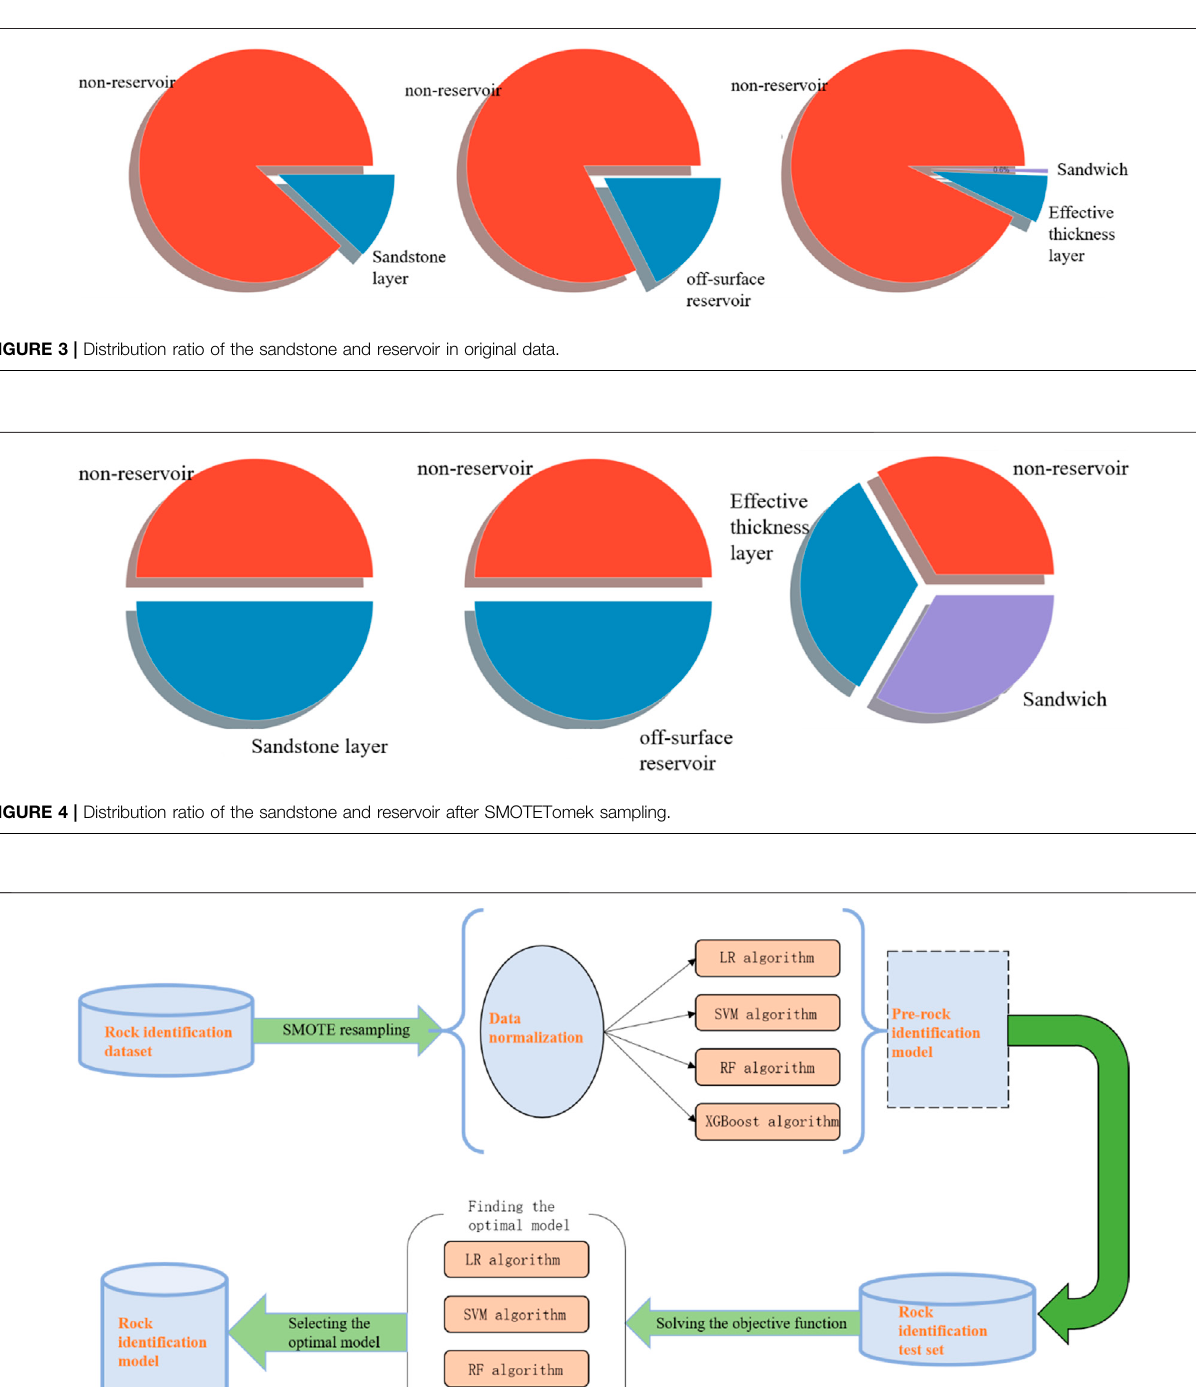
Frontiers in Earth Science |